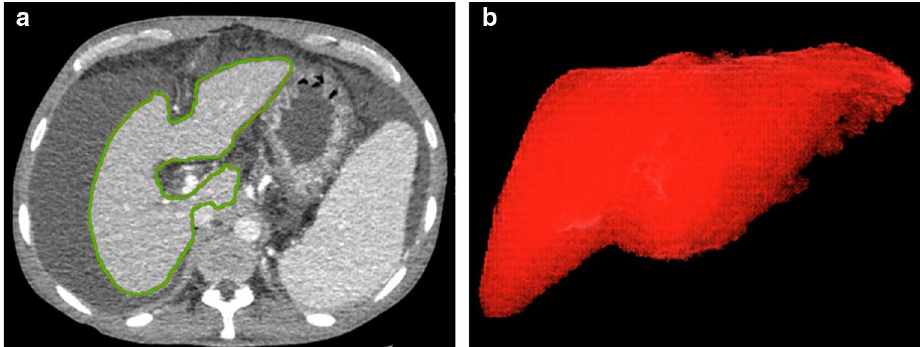
Figure 2. Liver volume was measured on images of enhanced CT at venous phase ( 2a ), with software (AW 4.7, total liver and segment separation), and finally the whole liver volume would be calculated automatically and shown with volume rendering ( 2b ).